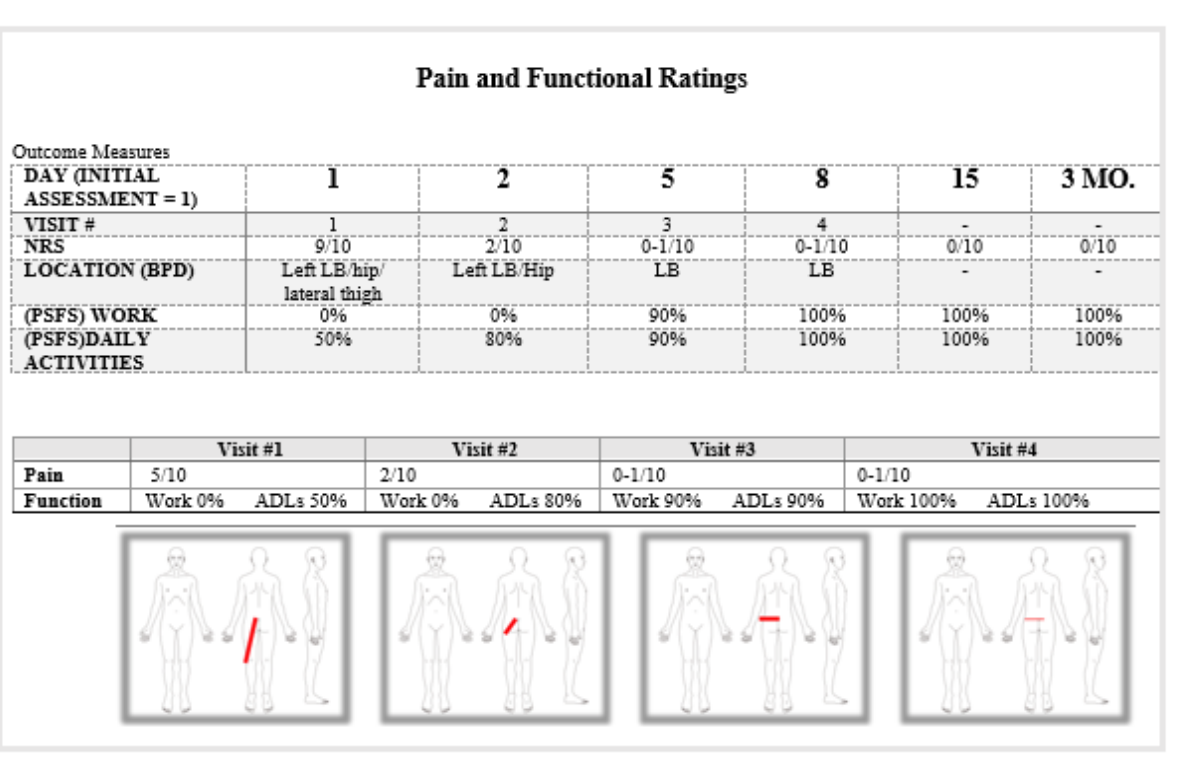
Figure 3. Self-correction of a (contralateral right) shift in standing. Table 2. Patient #1 - Low Back and Left Hip/Lateral Thigh